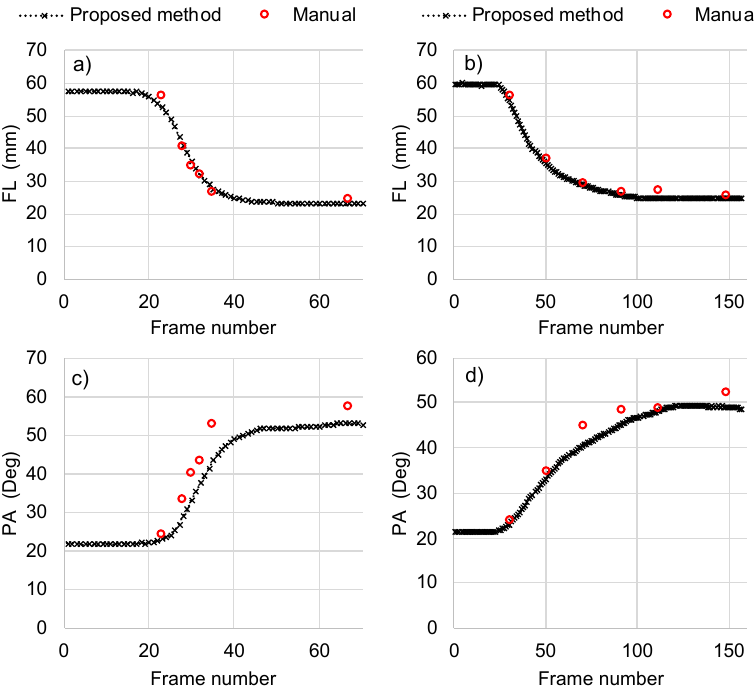
Figure 7. Comparison between the automated calculations using the proposed algorithm and manual measurements of fascicle length (FL) ( a , b ) and pennation angle (PA) ( c , d ). Results are presented separately for the contraction where the difference between computerized and manual measurements was the highest ( a , c ) and for a contraction where it was the lowest ( b , d ). More specifically, graphs ( a , c ) correspond to an ankle plantar flexion contraction at 500 deg/s, graphs ( b , d ) to ankle plantar flexion at 30 deg/s. For comparison, the respective root mean square errors (RMSE) between computerized and manual measurements are also shown.